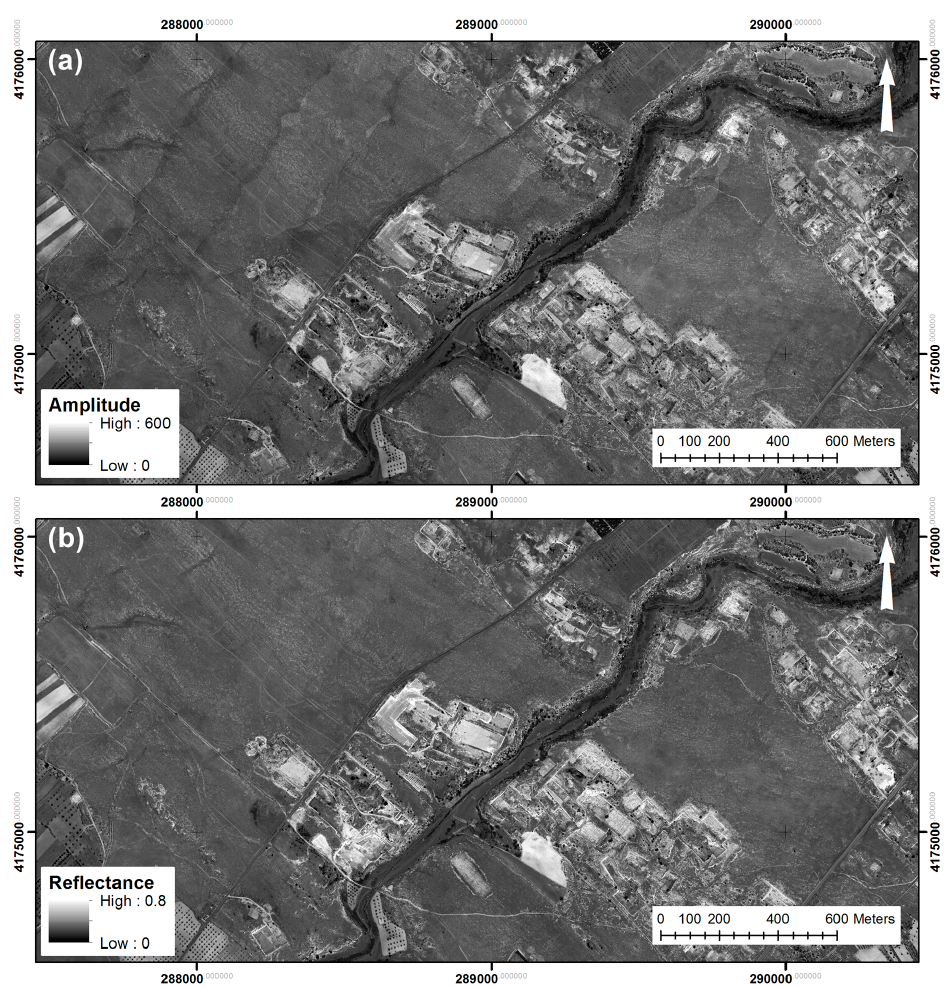
Figure7. ( a )Uncalibratedamplitudemapofstrips; ( b )calibratedreflectancemapofstrips. Visualization: 1 m spatial resolution raster calculated using the median value of each cell. Coordinate system: WGS84 UTM Zone 33N.